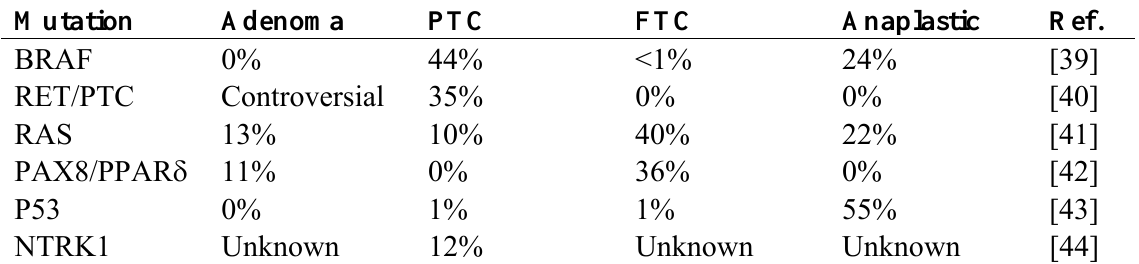
Table 1. Frequency of Sporadic Mutations in Thyroid Cancer by